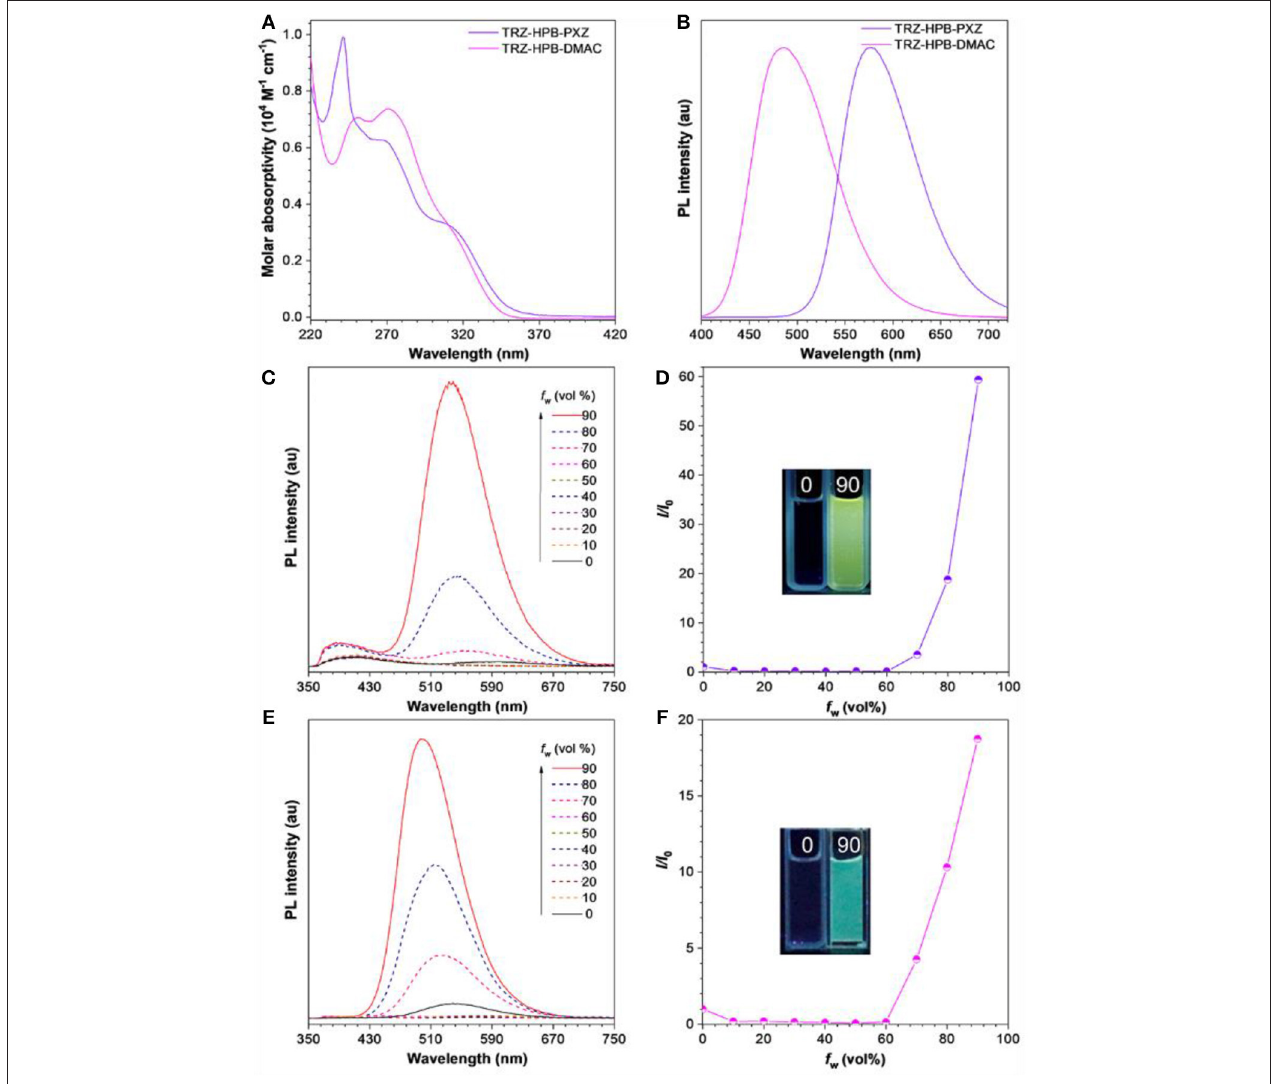
FIGURE 3 | (A) Absorption spectra of these HPB-based molecules in THF solutions (10 − 5 M). (B) PL spectra of these HPB-based molecules in neat films. PL spectra of (C) TRZ-HPB-PXZ, (E) TRZ-HPB-DMAC in THF/water mixtures with different water fractions ( f w ), Plots of I / I 0 vs. f w of (D) TRZ-HPB-PXZ, (F) TRZ-HPB-DMAC. I 0 is the PL intensity in pure THF. Inset: photographs of these HPB-based molecules in THF/water mixtures ( f w = 0 and 90%), taken under 310 nm